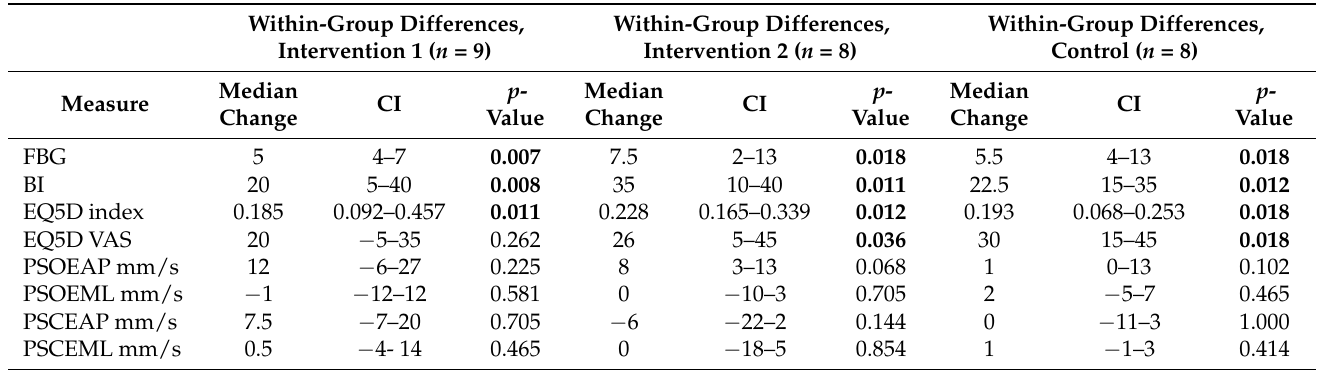
Table 4. On-treatment analysis of differences in change between baseline and follow-up within groups.